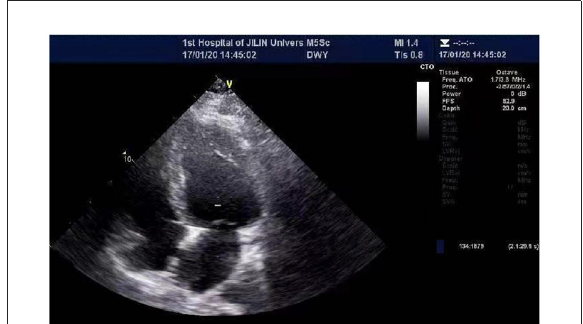
FIGURE1 Echocardiographic of the patient’s heart. The echocardiography revealed EF 29%, left atrial and left ventricle enlargement (left ventricular endomesosomal diameter 63mm), reduced ventricular wall pulsation diffusion, decreased left ventricular systolic and diastolic function, and trace pericardial effusion.